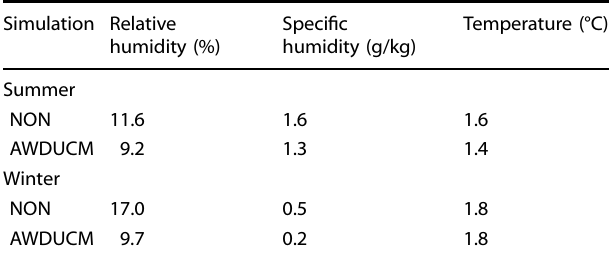
Table 1. Root mean square error of simulated meteorological variables at urban and suburban weather